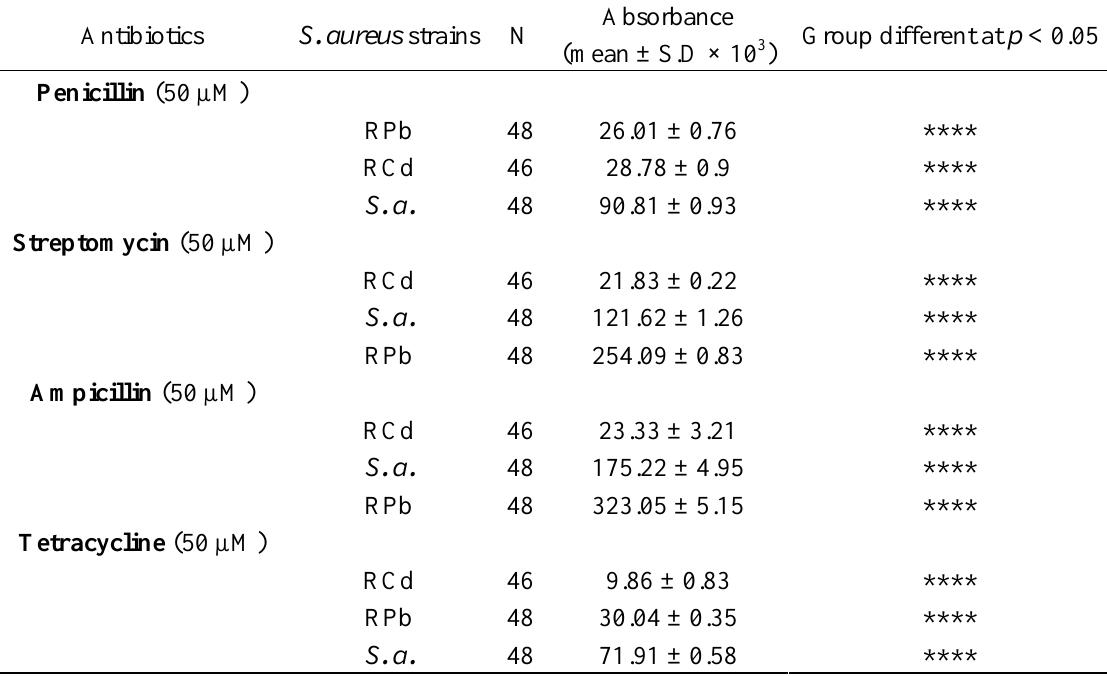
Table 1. Growth rate after application of 50 µM concentration of antibiotic in S. aureus non-resistant strain and strains resistant to cadmium and lead. Stars in columns indicate difference at p -level < 0.05 using Bonferroni post hoc test for homogenous groups. Absorbance Antibiotics S. aureus strains N Group different at p < 0.05 (mean ± S.D × 10 3 ) Penicillin (50